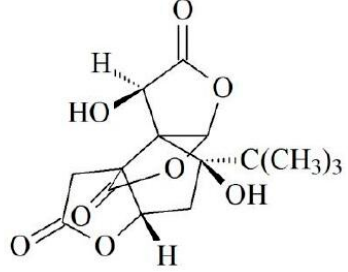
Figure 1. Chemical structure of Bilobalide.